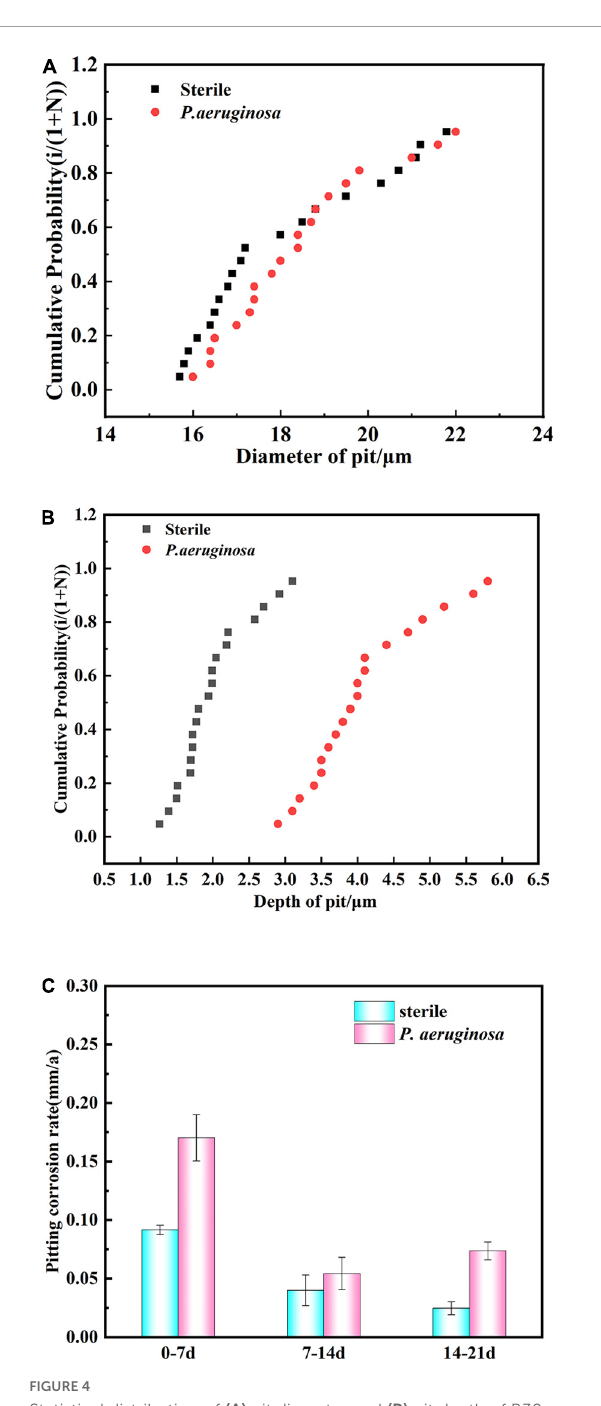
FIGURE4 Statistical distribution of (A) pit diameter and (B) pit depth of B30 copper–nickel alloy immersed in abiotic medium and P. aeruginosa for 21 days. (C) Pitting rate at different times of